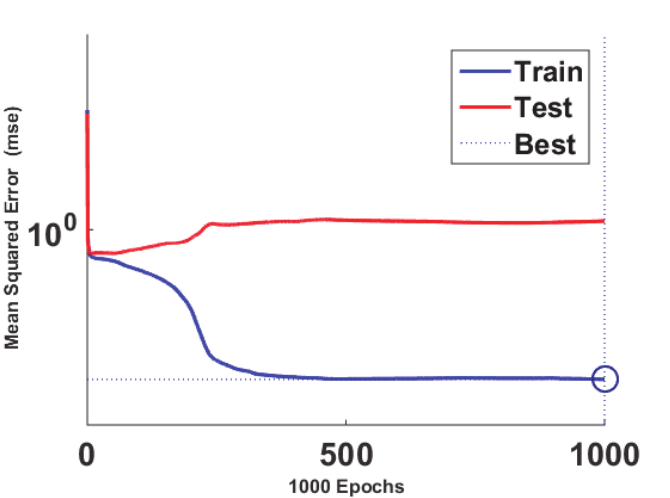
Fig. 5. The changes of performance index during the network’s training